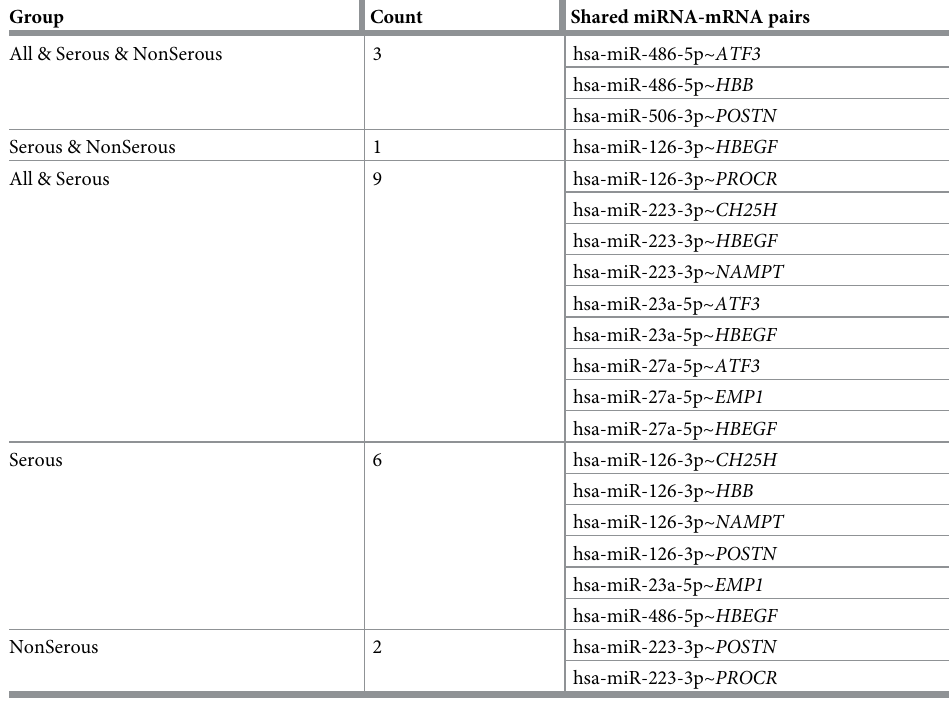
Table 3. Integrated miRNA and mRNA signatures associated with OS in two subgroups of a cohort of 197 patients: Serous adenocarcinoma (serous) and non-serous adenocarcinoma (NonSerous) compared to 12 miRNA- mRNA interactions identified in 197 patient cohort